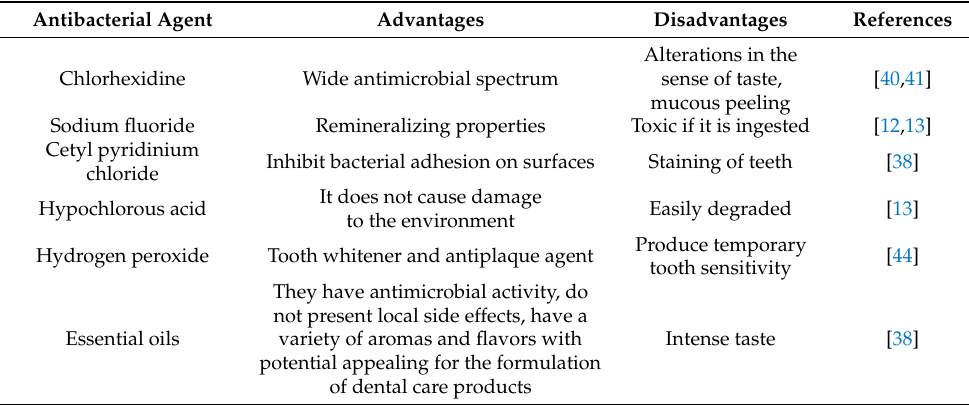
Table 1. General advantages and disadvantages of the most common antibacterial compounds used in commercial